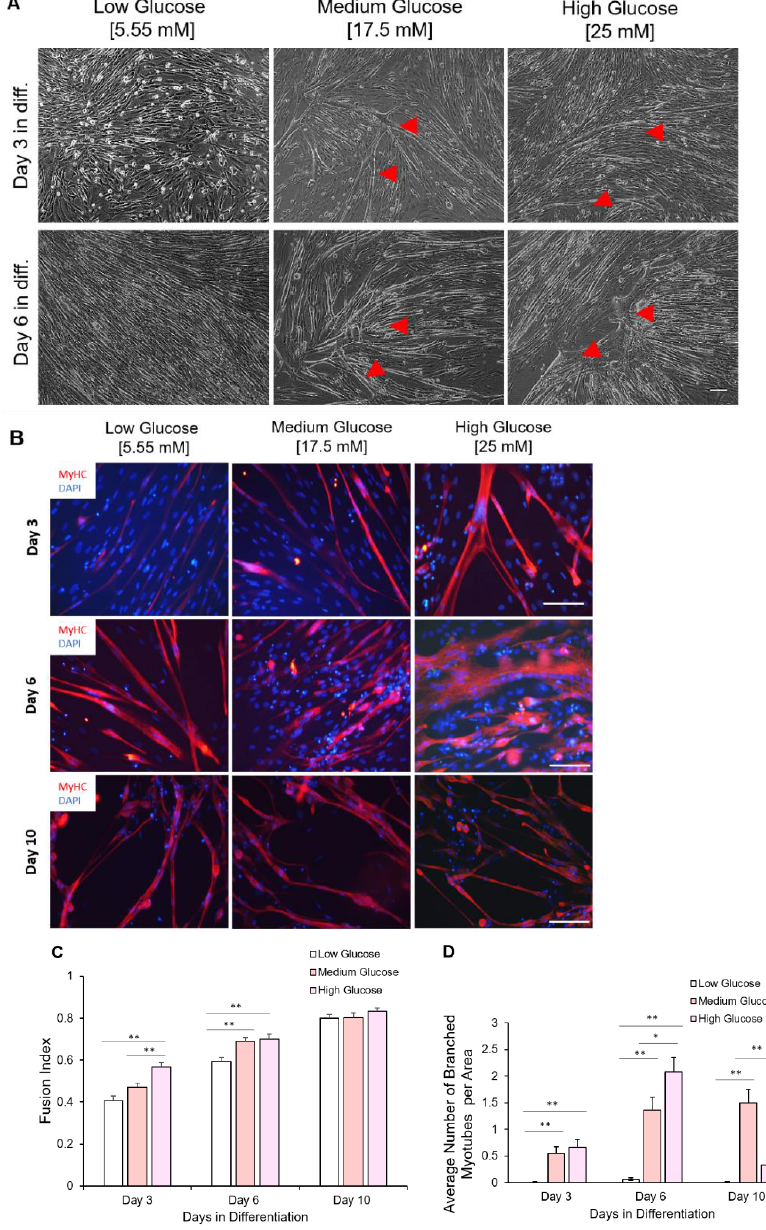
Figure 7. Chronological morphological and fusion index analysis of myotubes differentiated from iPSC-myoblasts expanded in the three D-glucose conditions. ( A ) Phase contrast imaging of myotubes at days 3 and 6 of differentiation. Myoblasts expanded under high glucose conditions tended to hyper-fuse and form branched myotubes (indicated by red arrows) after differentiation initiation. Scale bar = 100 µm. Red arrows pointing to branched hypertrophic myotubes. ( B ) ICC images of myotubes differentiated from iPSC-derived myoblasts previously cultured in the three D-glucose concentrations at days 3, 6 and 10 of differentiation. Myoblasts expanded under high glucose conditions tended to hyper-fuse and form branched myotubes after differentiation initiation. Those branched myotubes tended to detach sooner and few were left at day 10. Scale bar = 100 µm. ( C ) Quantification of Fusion Index of myotubes differentiated from iPSC-derived myoblasts previously proliferated in 5.55, 17.5 and 25 mM D-glucose at 3, 6 and 10 days of differentiation. ( D ) Quantification of branched myotubes per image area. Error bars = SEM. P ≤ 0.1, *; P ≤ 0.05, **; P ≤ 0.01, ***. n = 6. Statistics was performed utilizing One-way ANOVA with post-hoc Tukey HSD Test.